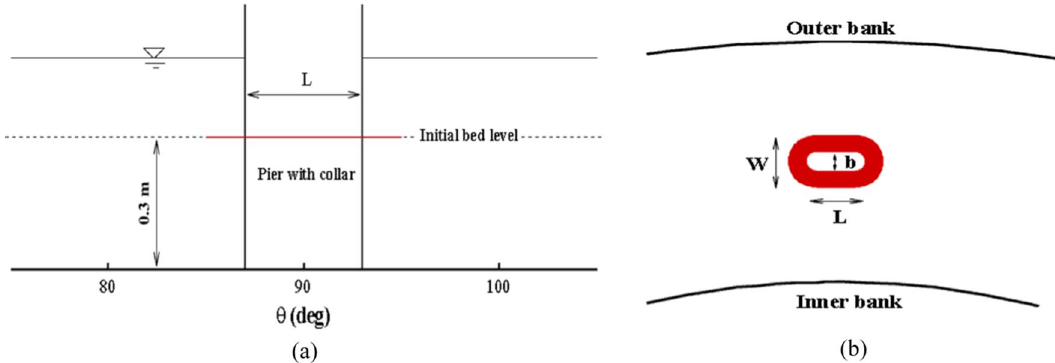
Fig. 1 a Lateral and b plan views of a combination of pier and collar in the bend